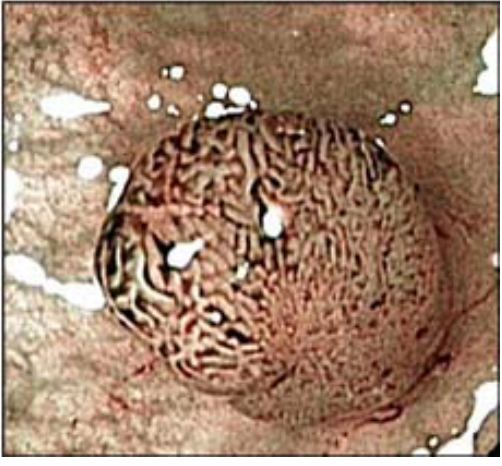
FIGURE 17. Colon “ sessile small adenomatous polyp; narrow-band imaging coupled to magnification. Pit pattern classified as III L (